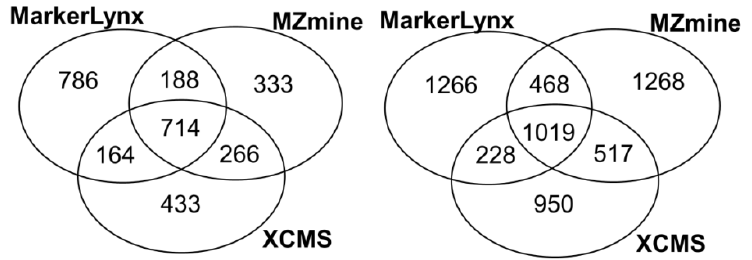
Figure 1. Venn diagrams illustrating the number of common and method specific features extracted from three software tools (right: positive mode; left: negative mode).